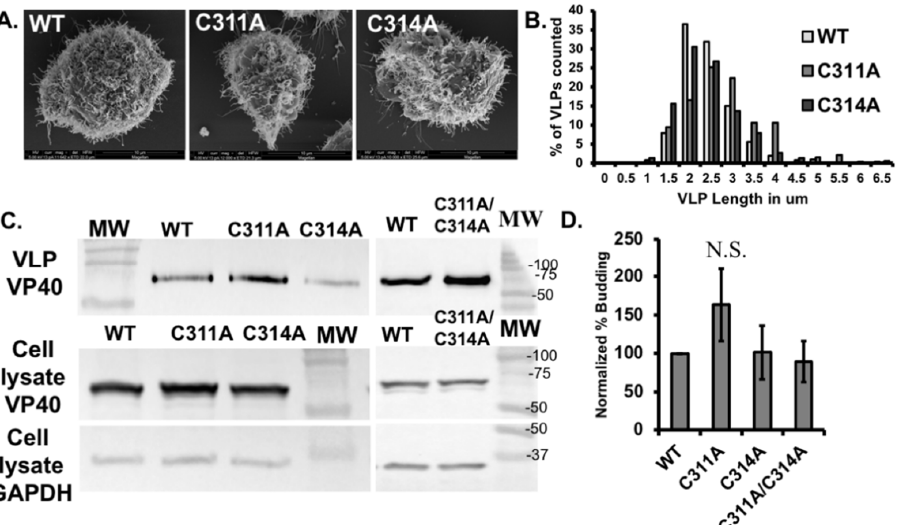
Figure 9. VLP filament length and budding efficiency assessment for WT-VP40 and cysteine muta- tions. ( A ) Representative scanning electron micrographs of EGFP-VP40-WT, and single mutants to show VLPs on the surface of the cell. ( B ) Histogram of VLP length for EGFP-VP40-WT and single mutants, values are represented as the percentage of the population of VLPs at each length bin for each construct. ( C ) Western blot of VP40 in the cell lysate and VLP samples. GAPDH was used as the loading control for the cell lysates. ( D ) Normalized budding efficiency for EGFP-VP40-WT and single Cys mutants. Average values are normalized to WT budding efficiency and represent at least three independent experiments. Error bars are ± standard error of the mean. N.S. = not significant.